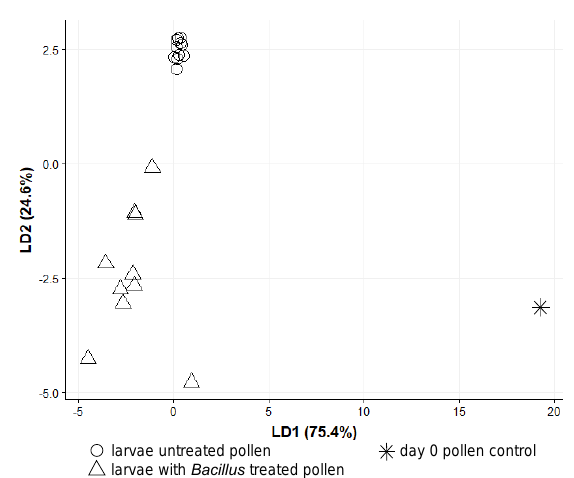
Figure 5. The two linear discriminants (LD1 and LD2) resulting from the linear discriminant analysis with (a) the original pollen sample used for feeding, (b) 11 larvae which fed on the aforementioned pollen sample, and (c) 10 larvae which fed on sterile pollen which was inoculated with one Bacillus sp. strain.